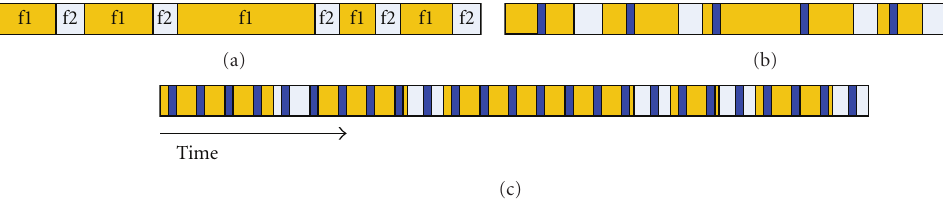
Figure 3: Tradeo ff s between accuracy and overhead in Profiling. (a) Original application execution. (b) Profiling with low sampling frequency. (c) Profiling with high sampling